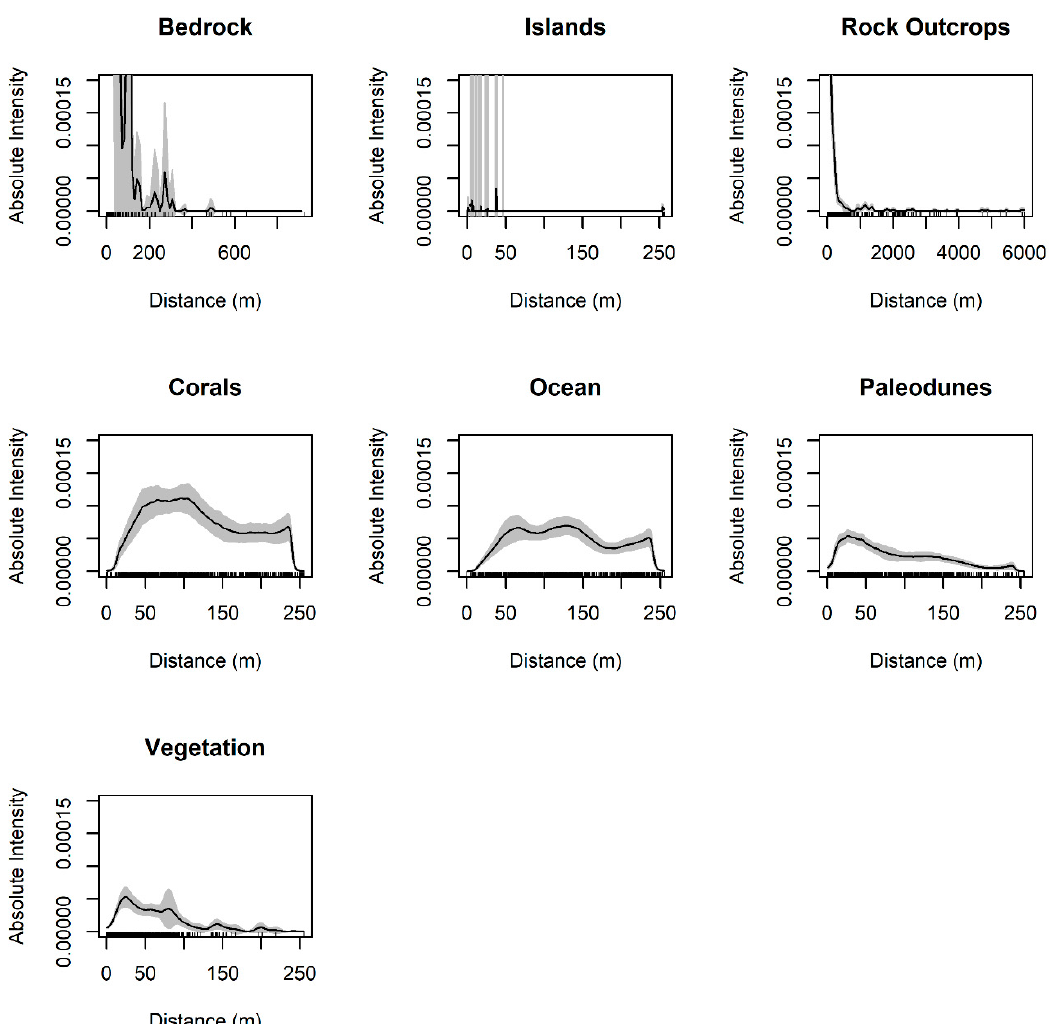
Figure 5. First order intensity of archaeological deposits (per m 2 ) weighted by artifact counts as a function of different environmental variables using nonparametric smoothing (rho-hat test). Likewise to the unweighted rho-hat tests, bedrock, islands and rock outcrops have the highest absolute intensity values, while dunes and vegetation have the lowest.